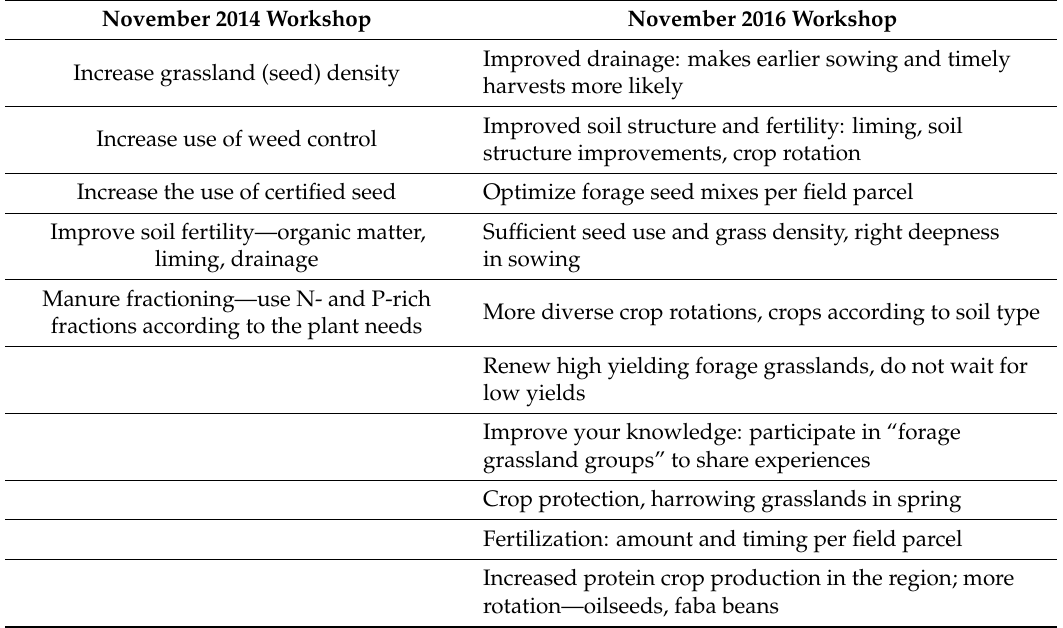
Table 3. Responses of farmers and close stakeholders to the question “What would you recommend for farmers who aim to achieve higher crop yields?” in the November 2014 and November 2016 workshops. The responses listed first were most frequently